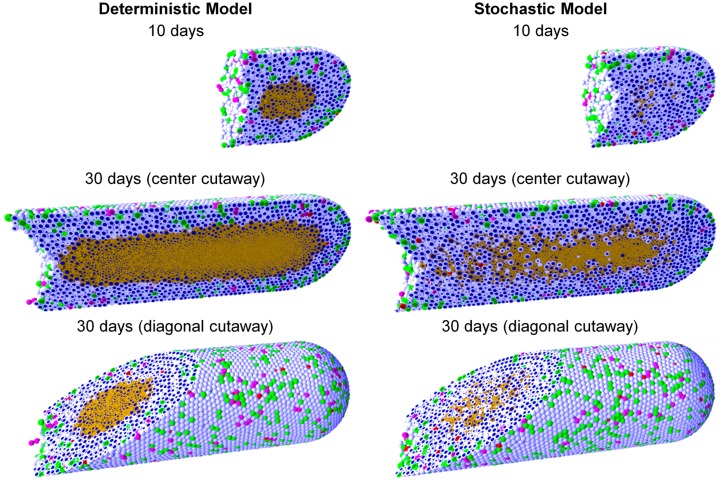
Ductal carcinoma in situ (DCIS) simulations with deterministic necrosis (left) and stochastic necrosis (right), plotted at 10 and 30 days (multiple views).Videos are available at S3 and S4 Videos. The legend is the same as Fig 2.